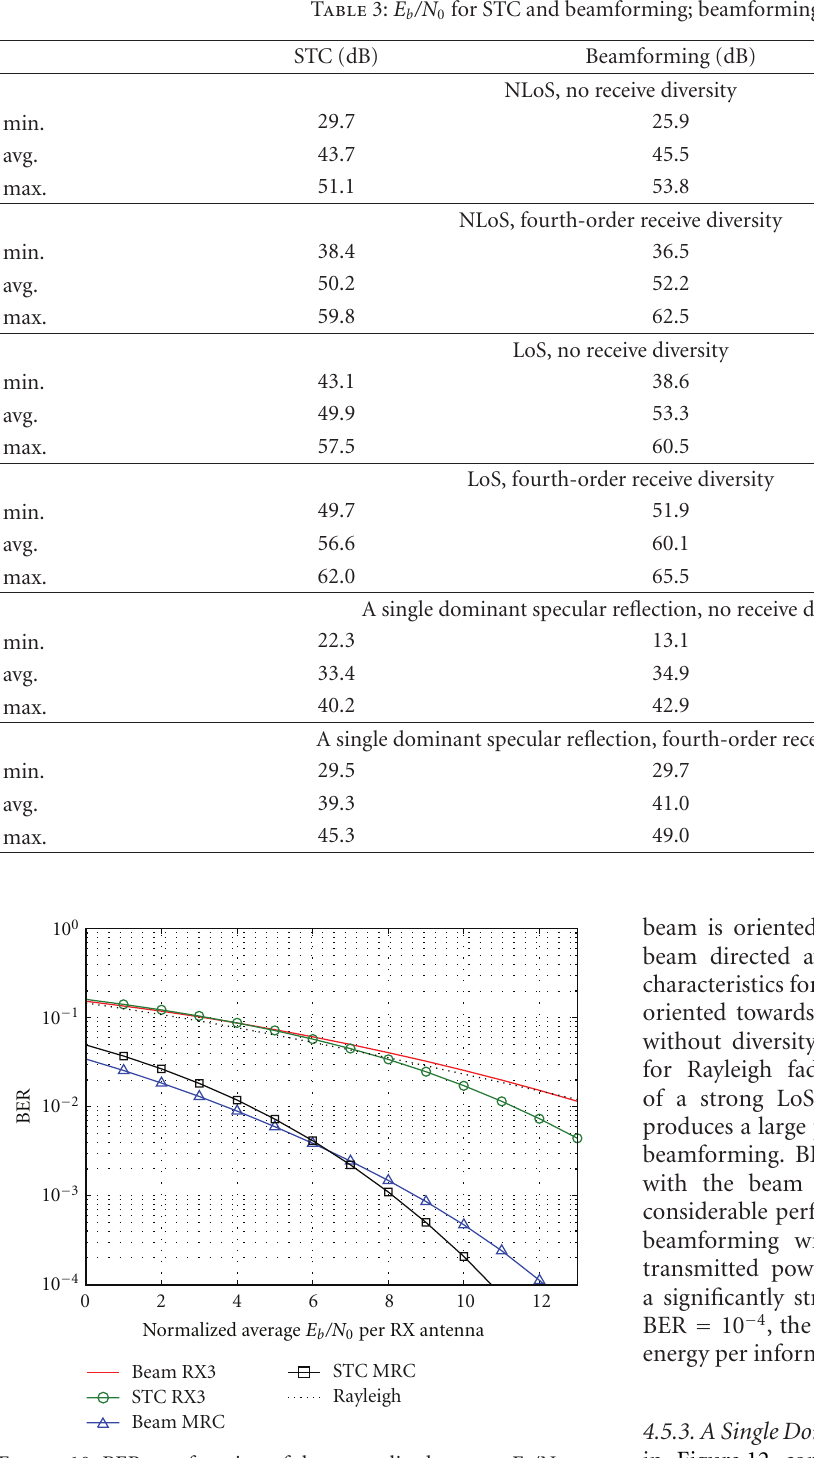
Figure 10: BER as a function of the normalized average E b /N 0 per receive antenna, recorded along the NLoS path, for transmissions at equal total E b ,tr